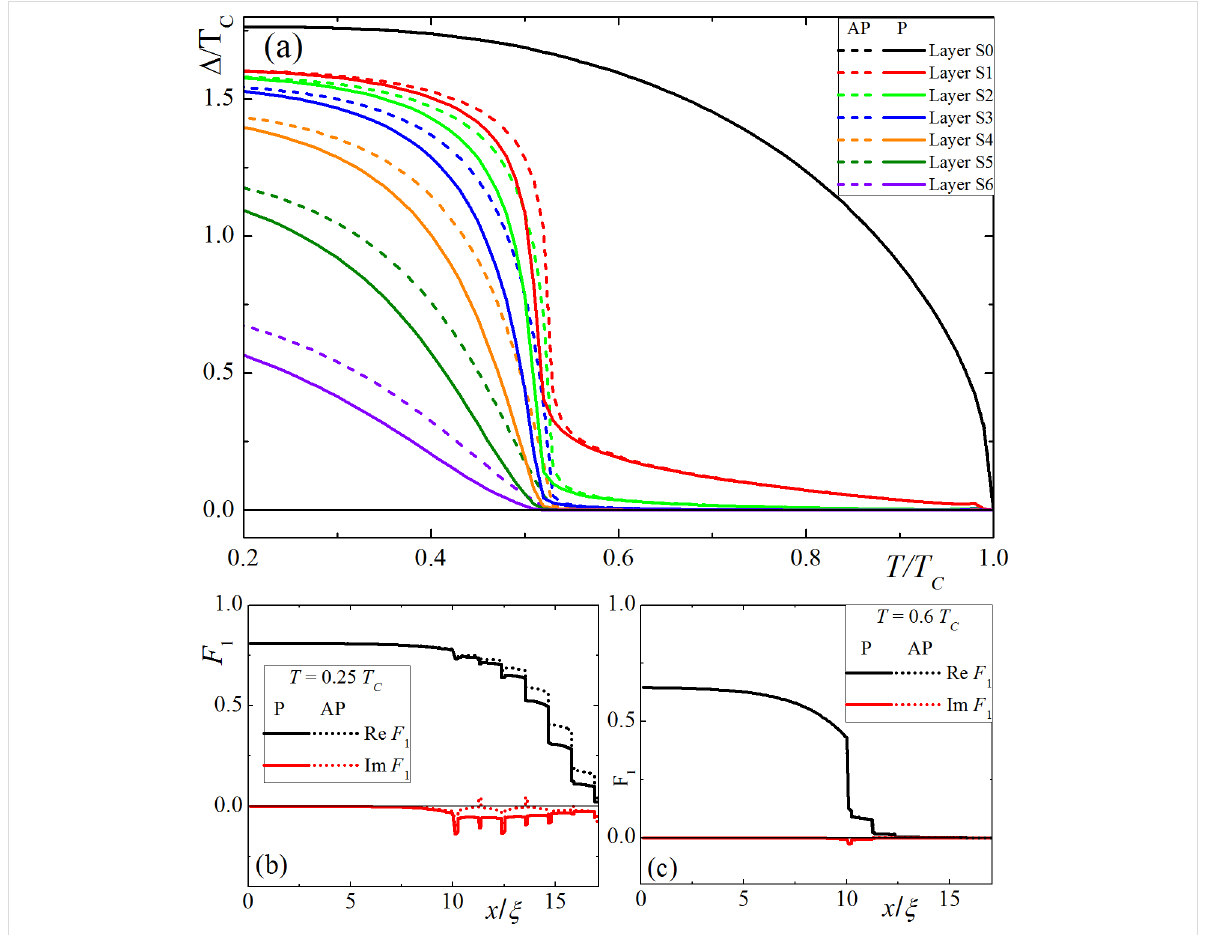
Figure 3: (a) Pair amplitude, Δ , in a S(F1sF2s) x3 F1 structure in different superconducting layers as a function of temperature, T , for parallel (solid lines) and antiparallel (dashed lines) magnetization orientations, considering γ = 0.1. (b,c) Spatial distributions of the anomalous Green’s function, F , for parallel (solid lines) and antiparallel (dashed lines) magnetization orientations at different temperature values: T = 0.4 T C (b) and T = 0.6 T C (c) .